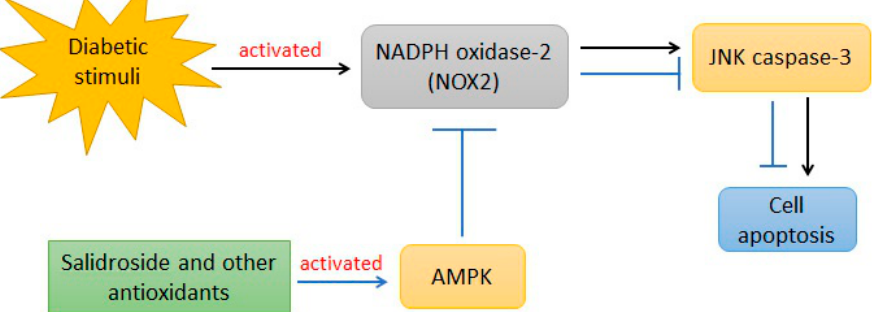
Figure 4. The salidroside mechanism in preventing oxidative diabetes (modification from Ju L et al., 2017) [121].